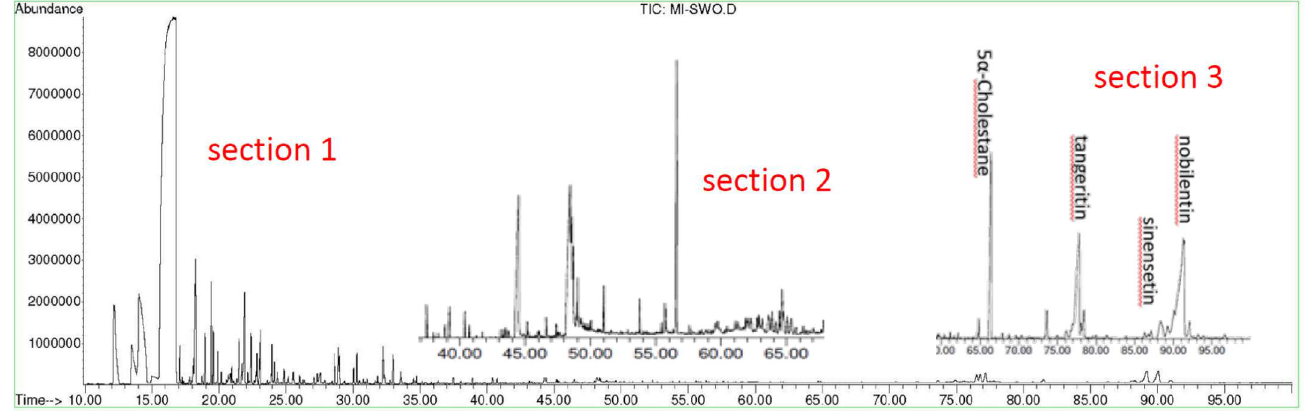
Figure 1. Chromatogram of cold-pressed orange essential oils obtained by GC/MS.